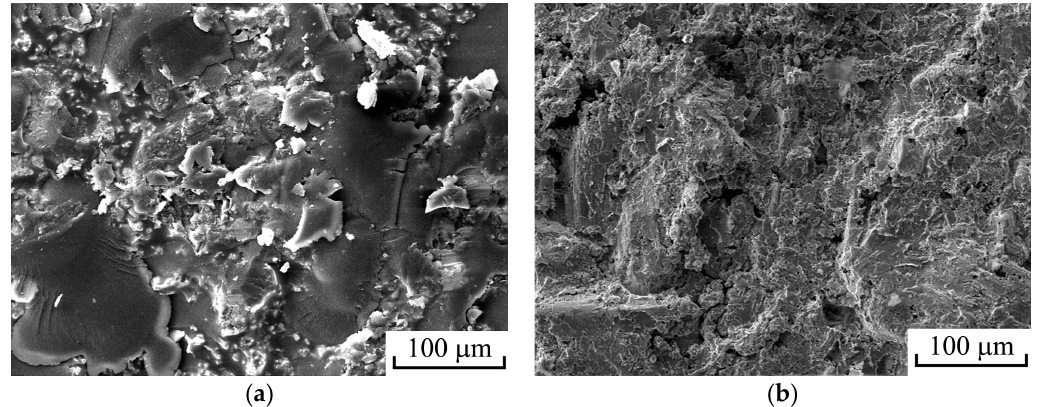
Figure 11. Fracture surface morphology of the coatings after adhesion strength test ( a ) and the as-sprayed coating ( b ) at 990 °C for 20 min.